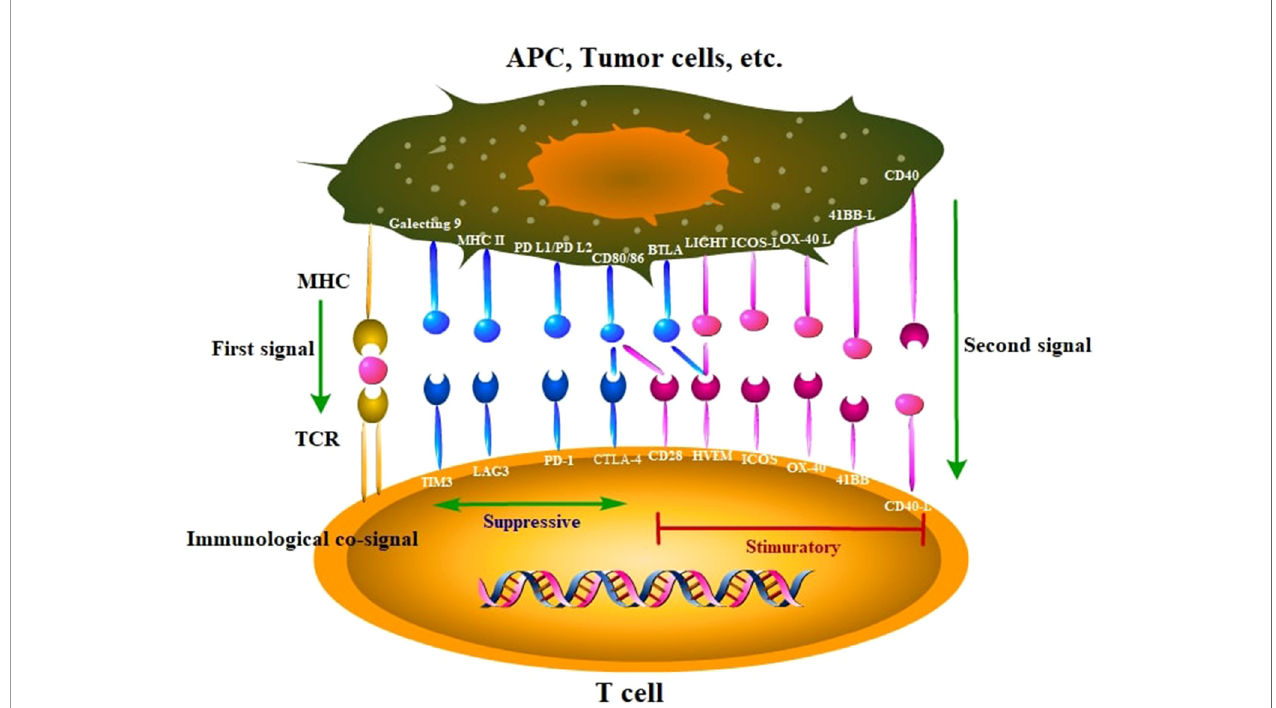
FIGURE 1 | Main immune molecules and corresponding receptors that suppressive or stimulatory immune responses. These ligands and cognate receptors expressed in tumor cells and immune cells are known as immune checkpoints. APC, antigen presenting cell; MHC, major histocompatibility complex; TCR, T-cell